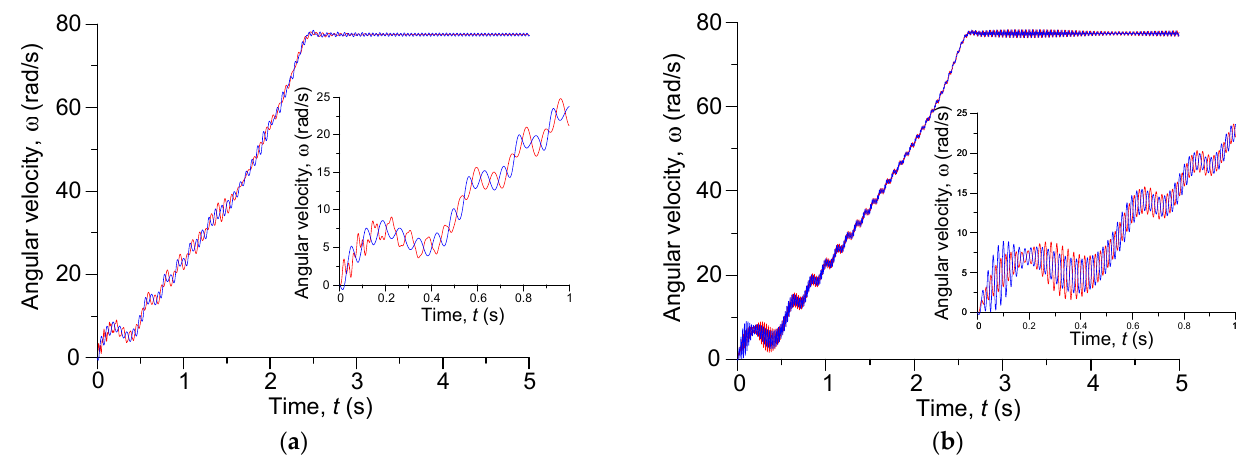
Figure 9. Angular velocity of two shafts versus time for the α 1,2 = α 2,3 = π /5 and shaft diameter: ( a ) D = 0.1 m; ( b ) D = 0.192